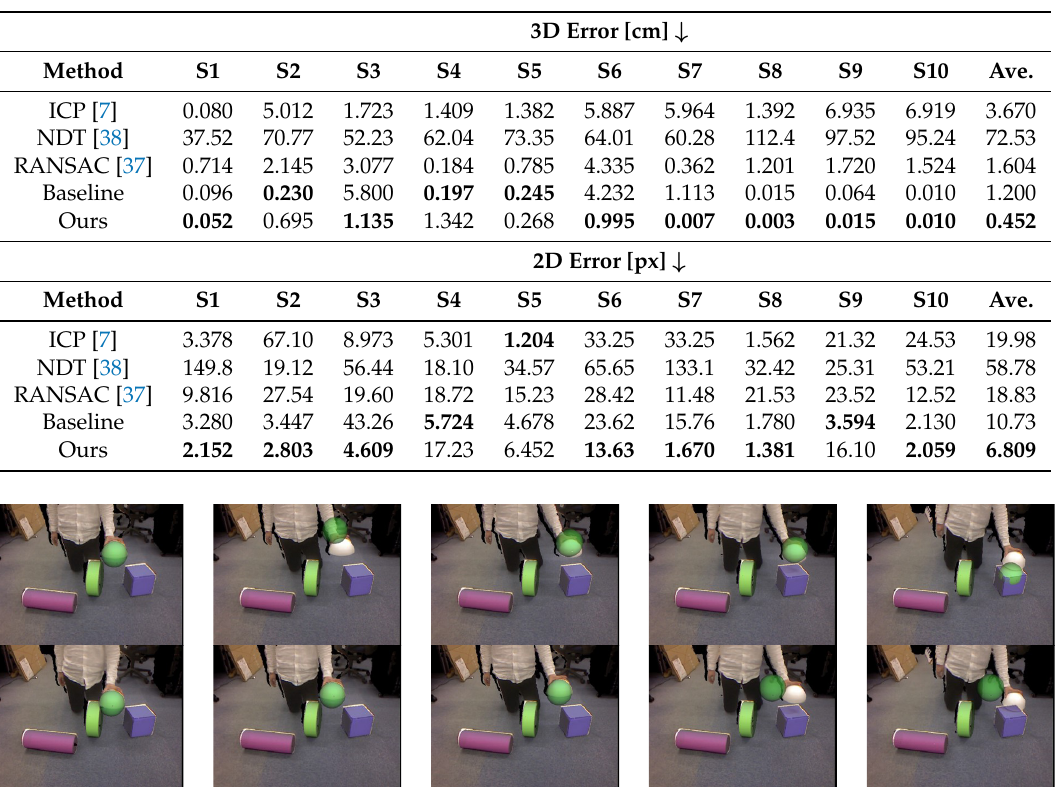
Figure 8. The failure of the proposed method. The upper row shows the results of the baseline method and the bottom row shows the results of the proposed method. The column shows the five successive frames in the